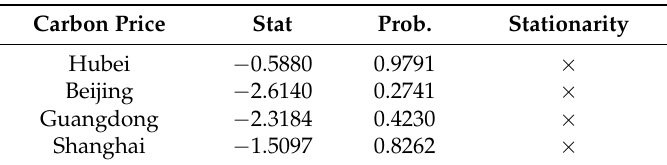
Table 3. ADF test results.